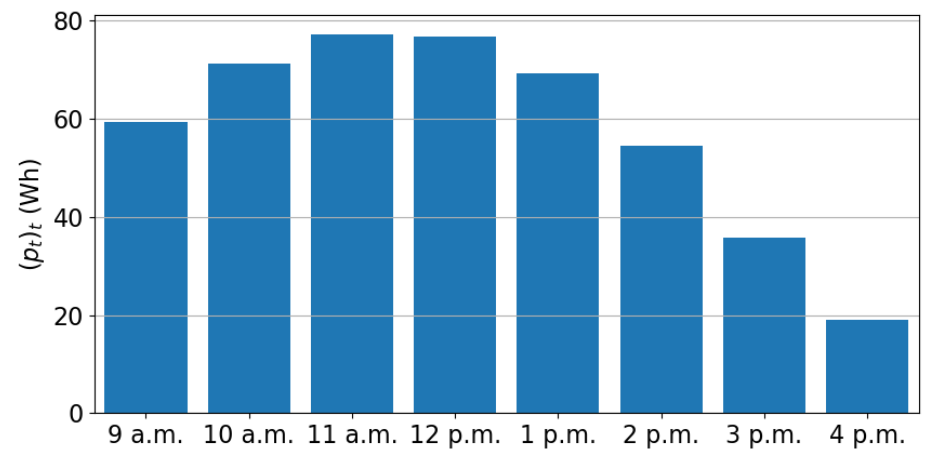
Figure 3. Energy produced by 1 m 2 (equivalent to a nominal power of 175 Wp) of a solar panel in Paris during working hours (averaged over the year